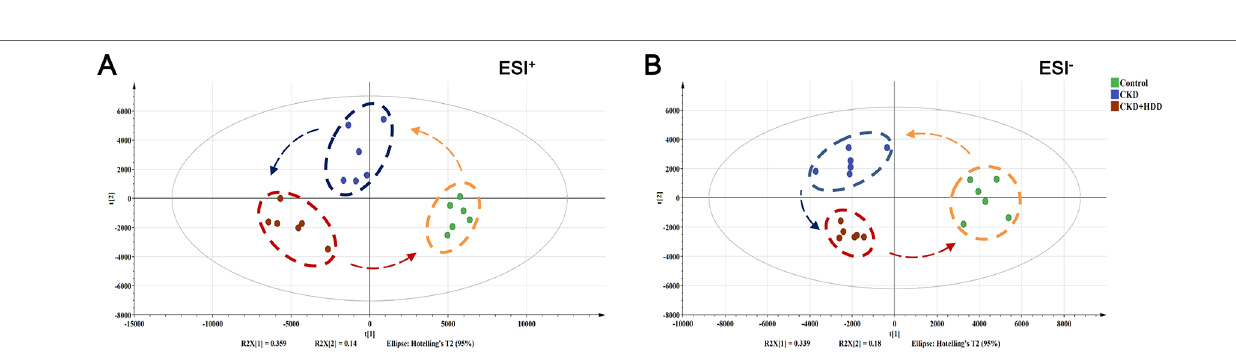
FIGURE 6 | Effect of HDD on the metabolic profiling by PLS-DA score plots. (A) PLS-DA score plot of positive ion mode. (B) PLS-DA score plot of negative ion